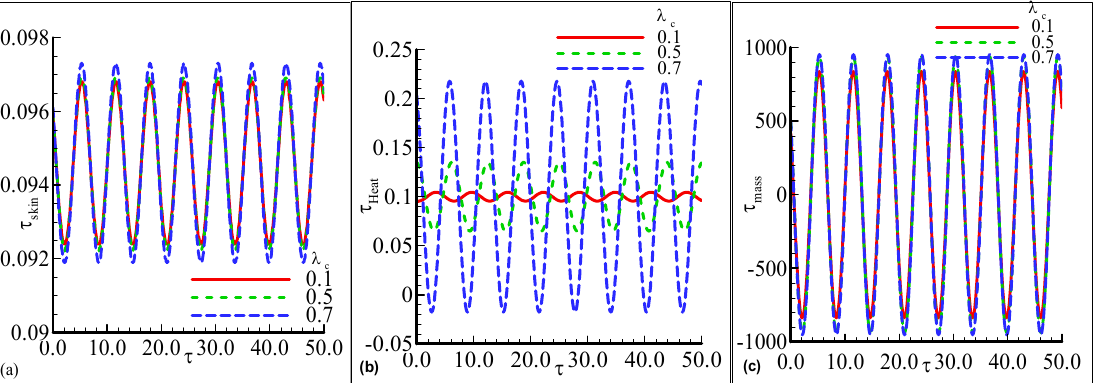
Figure 3. The physical profiles for τ skin , τ heat , and τ mass with choices of λ c = 0.1, 0.5, and 0.7 and fixed Pr = 7.0, S c = 0.2, λ t = 0.5, E = 0.1, γ = 0.3, λ = 0.5, β = 0.2, n = 0.3, and (cid:101) =